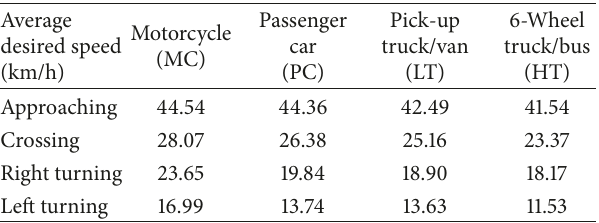
Table 1: Approaching, turning, and crossing speeds at intersections by vehicle